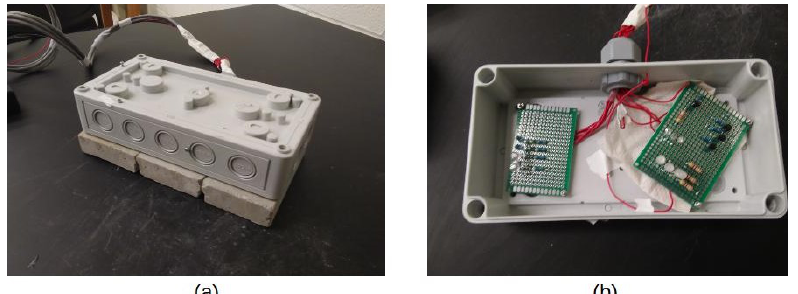
Figure 2. Image of D-SPARC showing ( a ) a measurement being performed and ( b ) the internal layout of the circuit.